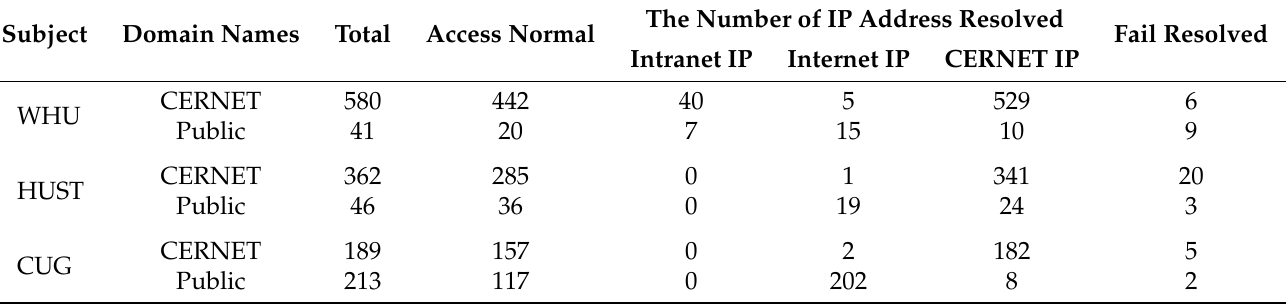
Table 10. Compliance audit of IP addresses and domain names.